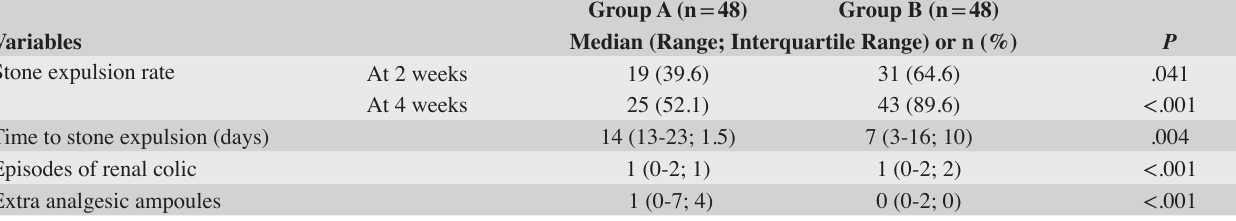
Table 2. Outcomes of Treatment in Both Groups